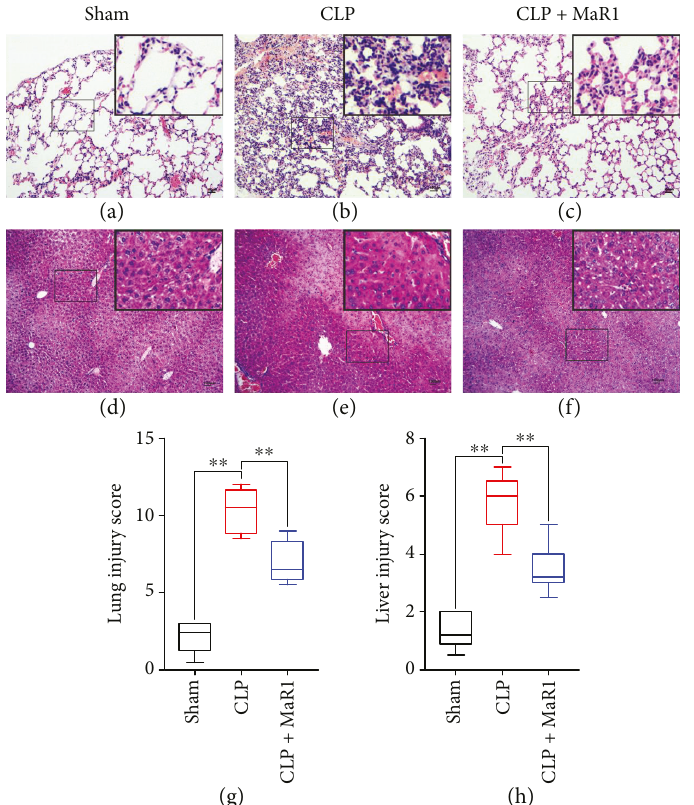
Figure 2: MaR1 attenuated lung and liver injury in CLP-induced septic mice. The lung and liver tissues were obtained immediately after exsanguination (24 h after CLP), and the e ff ect of MaR1 was assessed histologically in H&E-stained sections (original magni fi cation × 100). Inset shows 40x magni fi cation of the slides. (a-c) Lung tissues, (d-f) liver tissues, (g) lung injury scores ( n = 5 per group), and (h) liver injury scores ( n = 5 per group). Data are presented as mean ± SD . ∗ P < 0 05 and ∗∗ P < 0 01 , n = 5 per